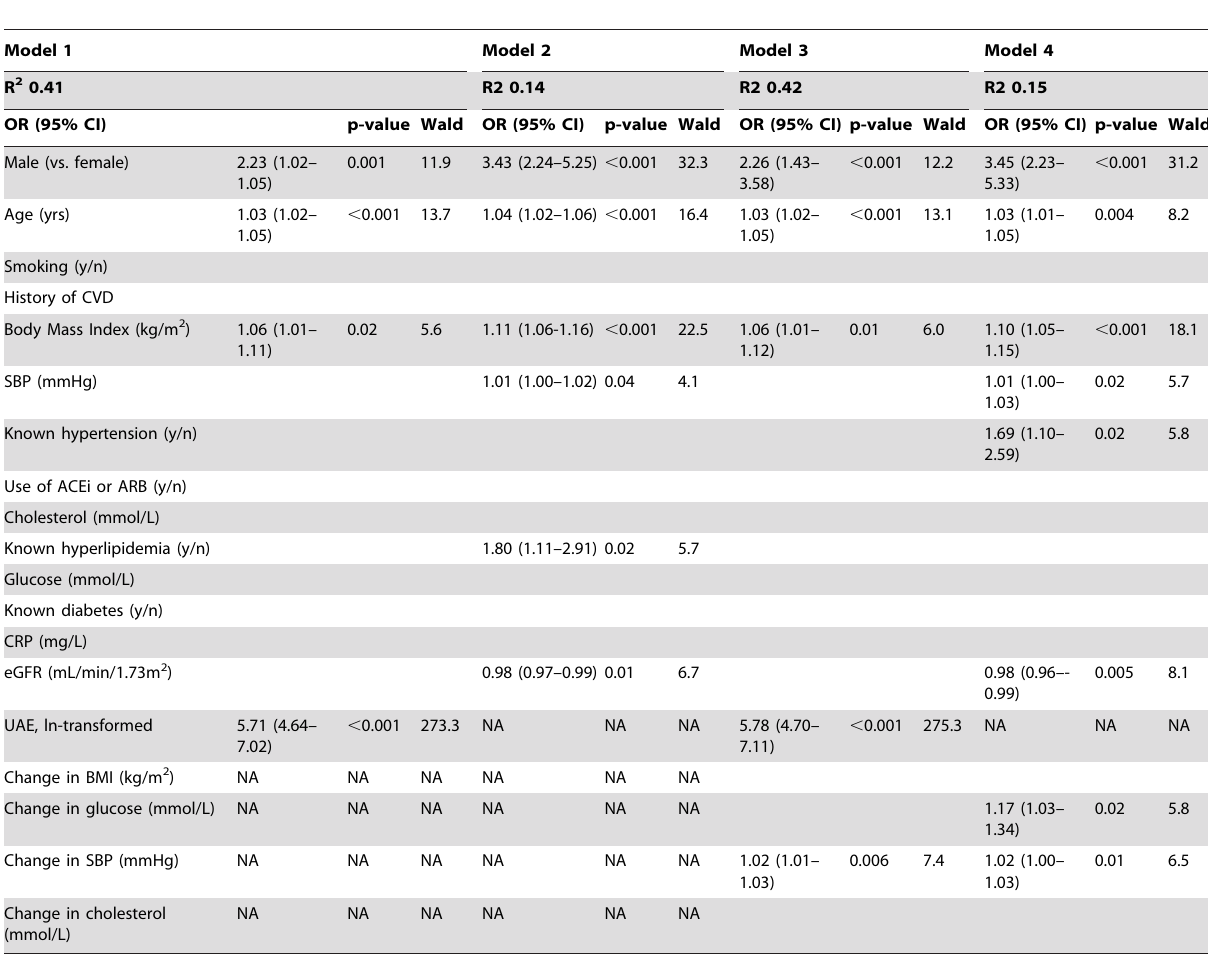
Table 3. Results of the multivariable logistic regression analyses exploring subject’s characteristics associated with progressive